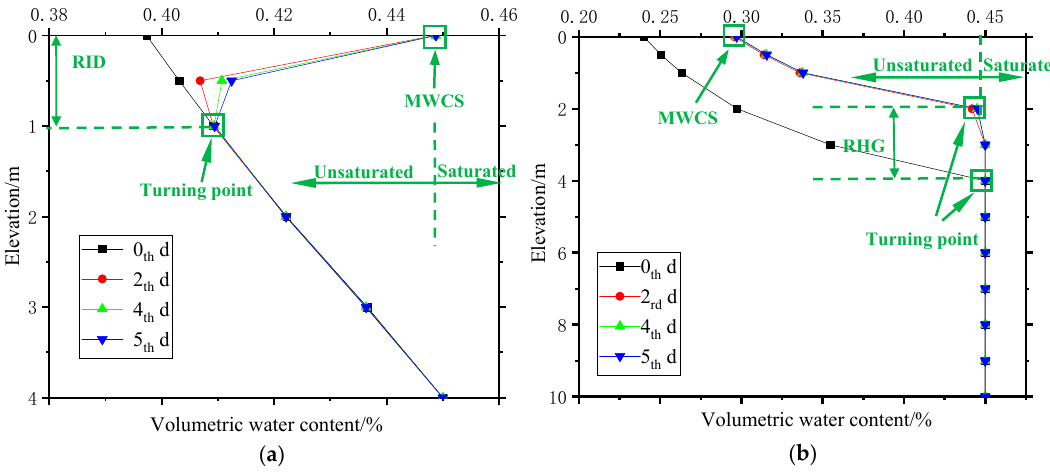
Figure 9. Variation of volumetric water content for sandy and clayey soil. ( a ) Sandy soil. ( b ) Clayey soil.